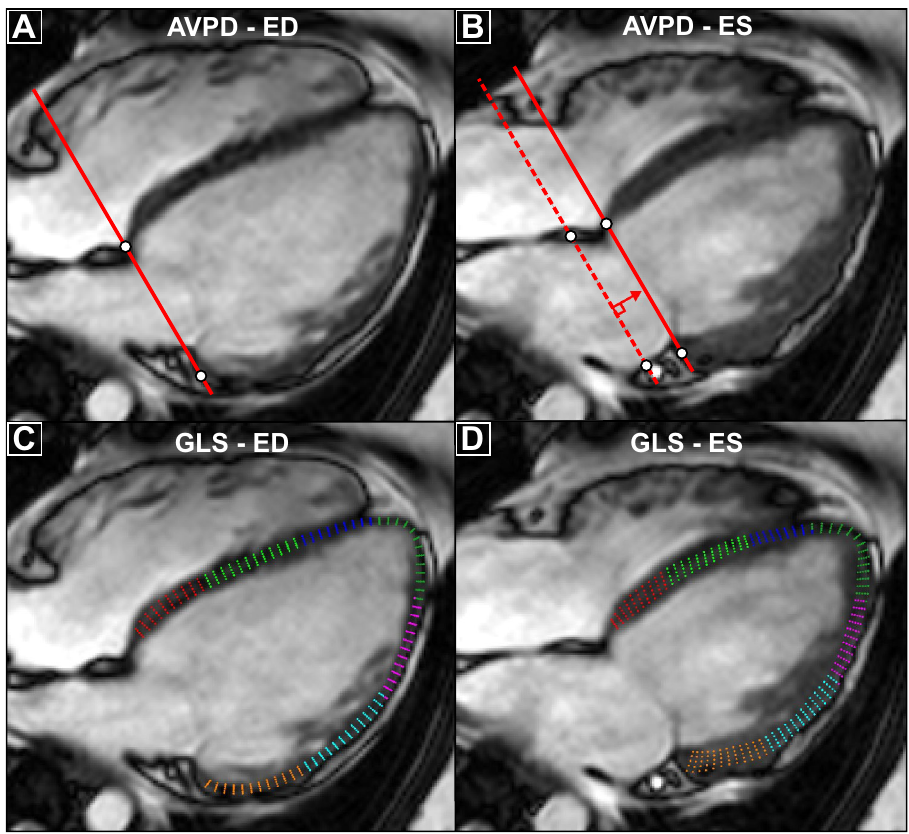
Figure 5. Measurement illustration. Illustration of how atrioventricular plane displacement (AVPD) and global longitudinal strain (GLS) were measured in a 4-chamber long-axis image. To obtain AVPD values (top row) annular annotation points are placed at the top of myocardium at end-diastole (ED, A ) and at end-systole (ES, B ). The perpendicular distance from the ED AV-plane to ES defines AVPD (red arrow, B ). For GLS (bottom row) the myocardium is manually delineated in ED ( C ) and used as input in the semi-automated feature- tracking algorithm. The average longitudinal strain for each colored segment defines